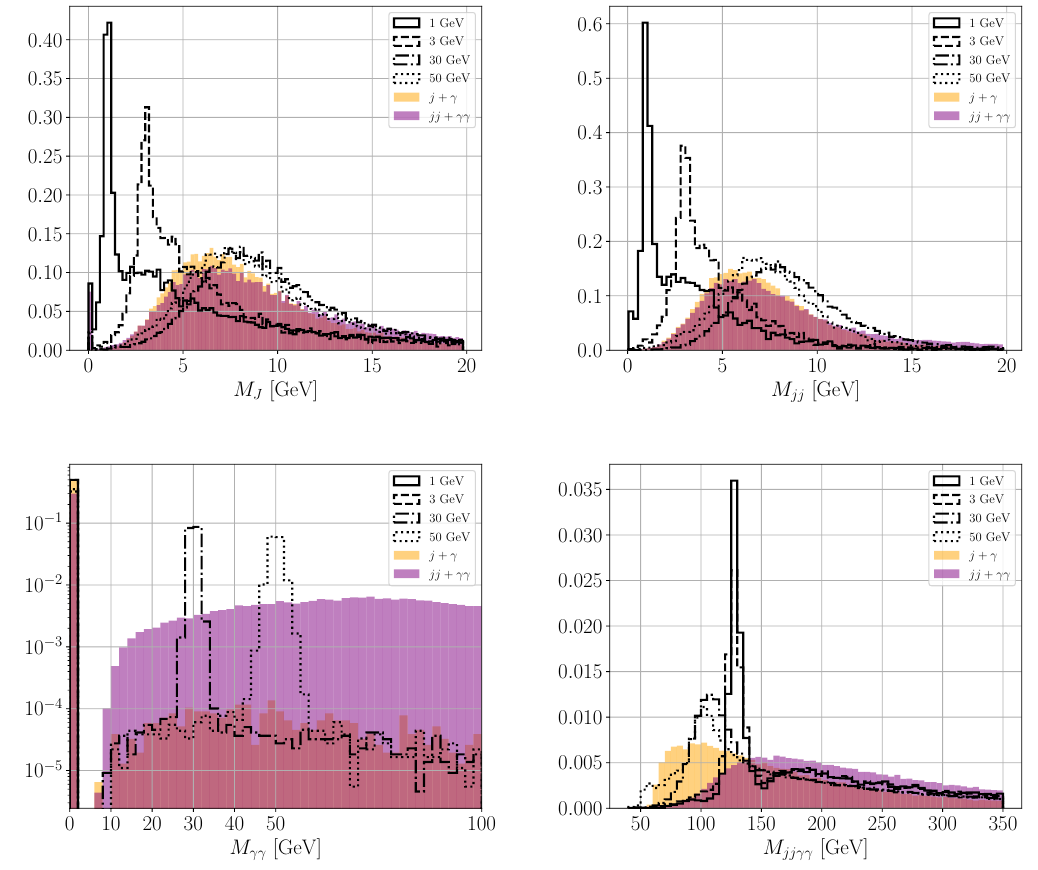
Figure 1 . The normalized invariant mass distributions of photon pairs (lower left), jet pairs (upper right), the mass of the leading p T jet, J (upper left), and the mass of j ( j ) + γ ( γ ) pairs (lower right). We display the distributions for ALP masses of 1, 3, 30, and 50 GeV and for the j + γ and jjγγ